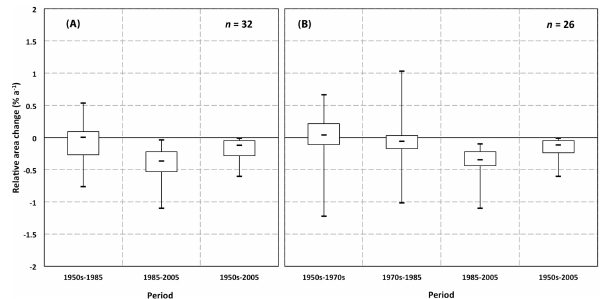
Figure 7. Box-and-whisker plots displaying maximum, interquar- tile range, median, and minimum of average annual rates of relative area change for (a) 32 glaciers for three periods and (b) for 26 indi- vidual glaciers for four